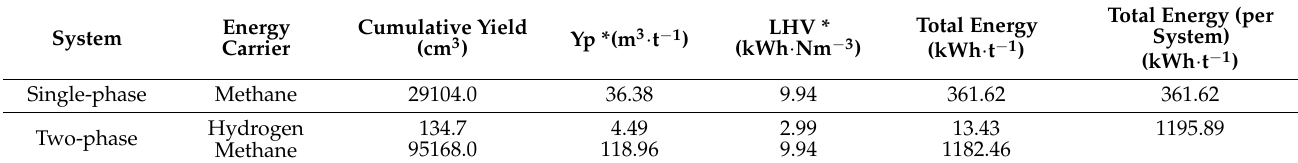
Table 1. Energy yield for the single-stage and two-stage anaerobic digestion systems.